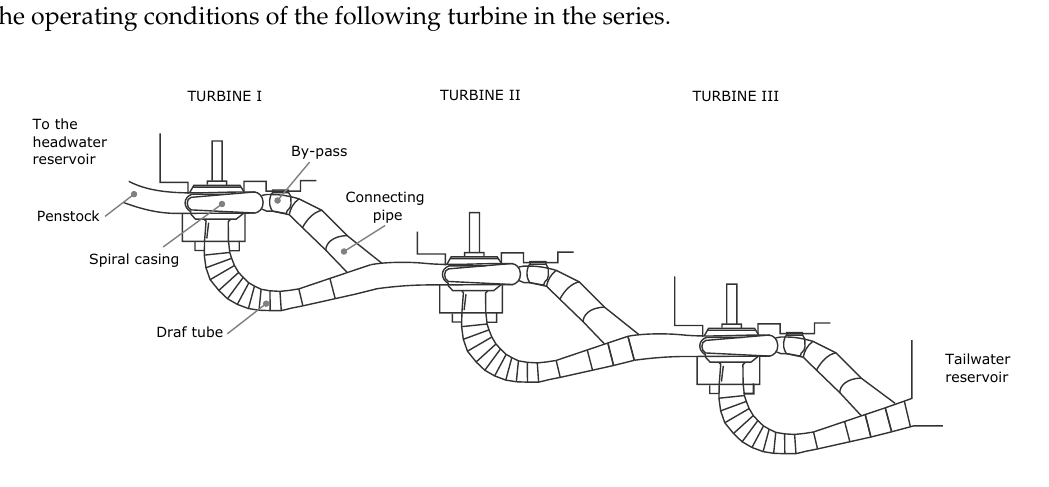
Figure 8. Schematic representation of turbine I (for 200 m gross head), II and III (both at 150 m gross head) in